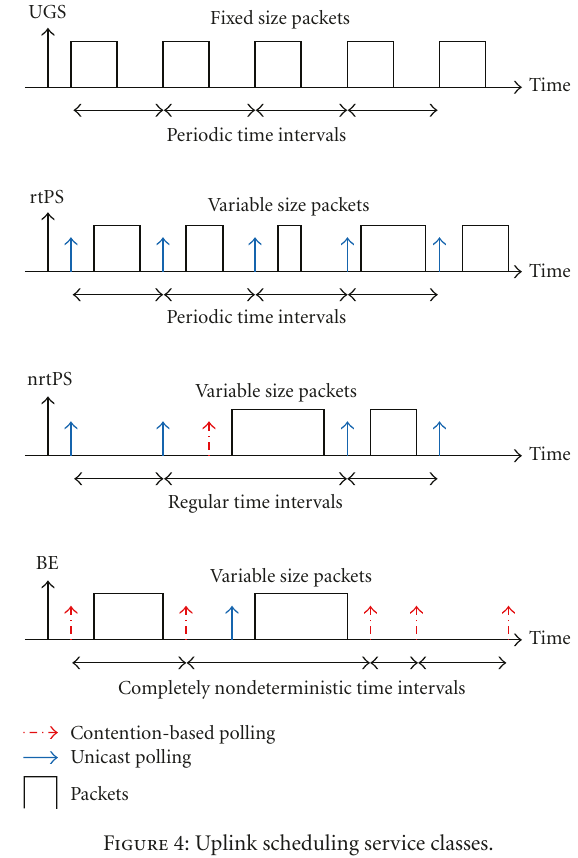
Figure 4: Uplink scheduling service